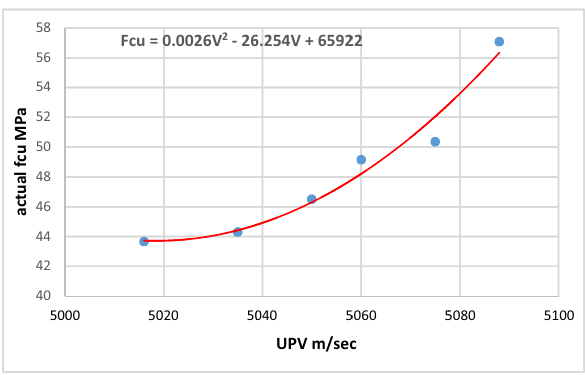
Figure 11: Ultrasonic pulse velocity and compressive strength rela - tionship for concrete with fi ber content from 0 to 1%.